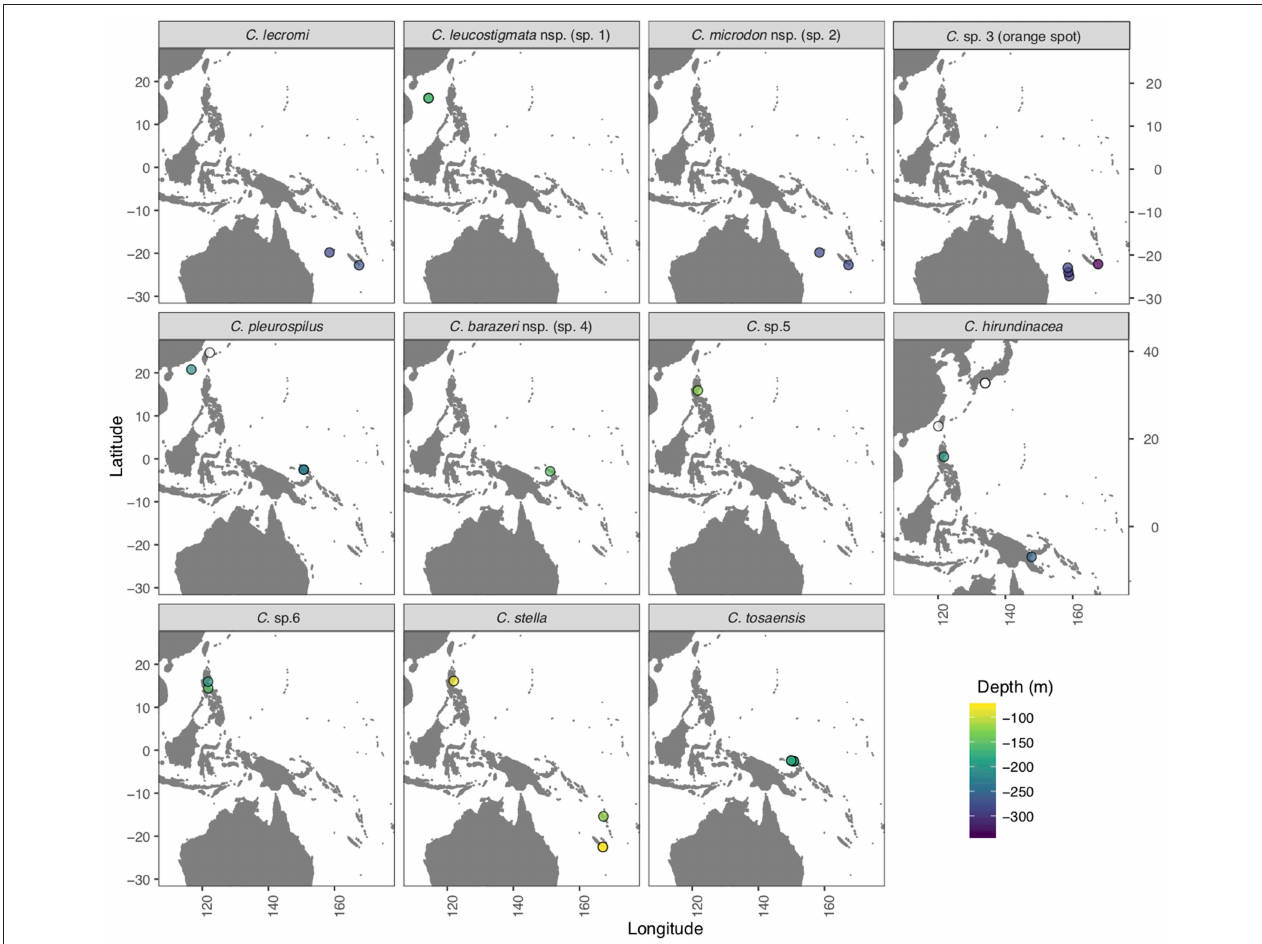
FIGURE 1 | Map of the West Pacific region indicating sampling sites (open and color filled circles) for the specimens of Chelidoperca species examined in the present study. Open circles: specimens collected from fish landing ports with unknown collection depths; color-filled circles: specimens collected during exploratory cruises through the TDSB program and its joint TFDeepEvo